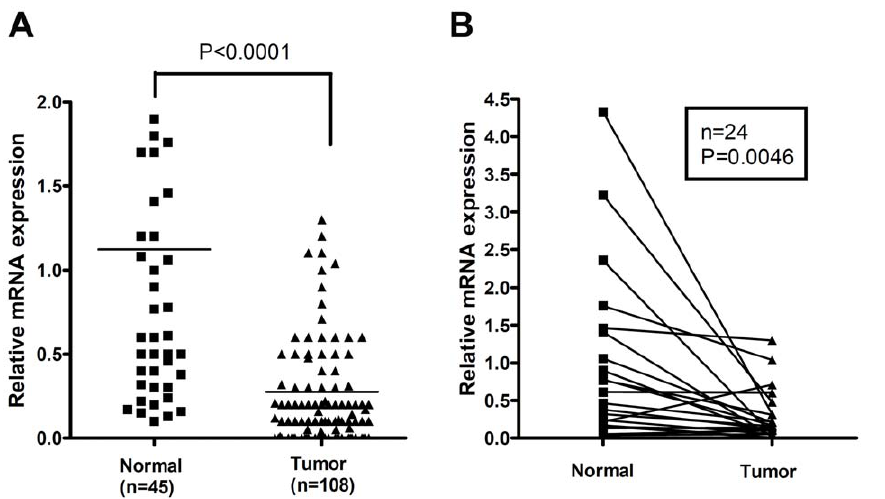
Figure 1. GPX3 is downregulated in gastric cancers. 108 gastric cancer samples and 45 tumor-adjacent histologically normal gastric mucosa samples were analyzed by real-time RT-PCR for GPX3 expression, which was significantly downregulated in gastric cancers as compared to adjacent normal samples (A). A similar result was confirmed in 24 matched normal and tumor samples from the same patients (B).